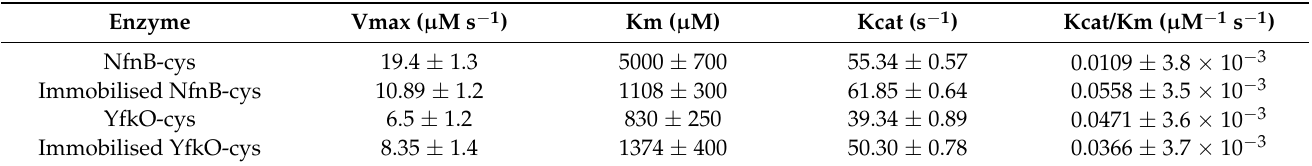
Table 1. Michaelis-Menten data obtained for free and immobilised YfkO-cys with varying concentrations of CB1954, compared to the data we have published previously for free and immobilised NfnB-cys [32]. Enzyme